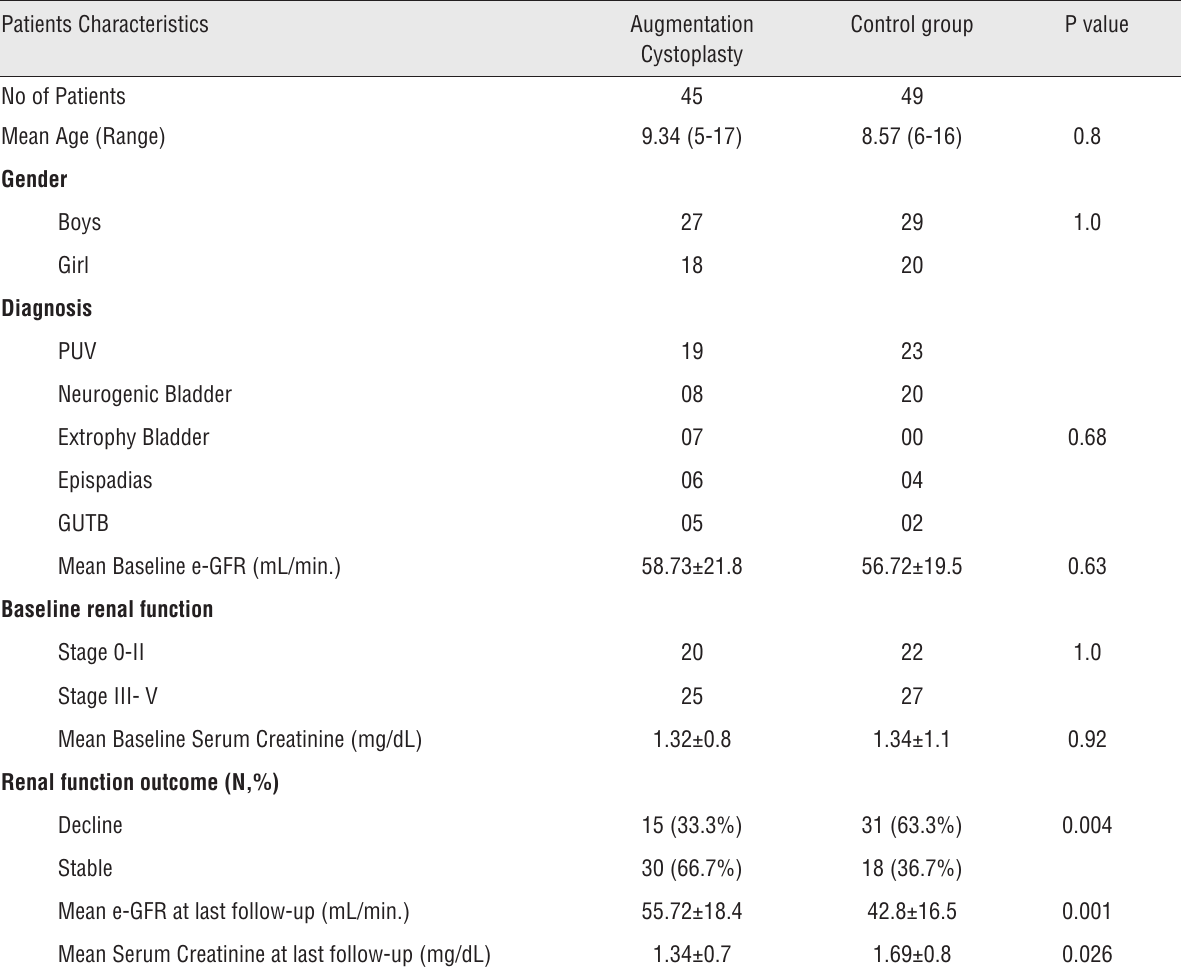
Table 1 - Patient Characteristics. Patients